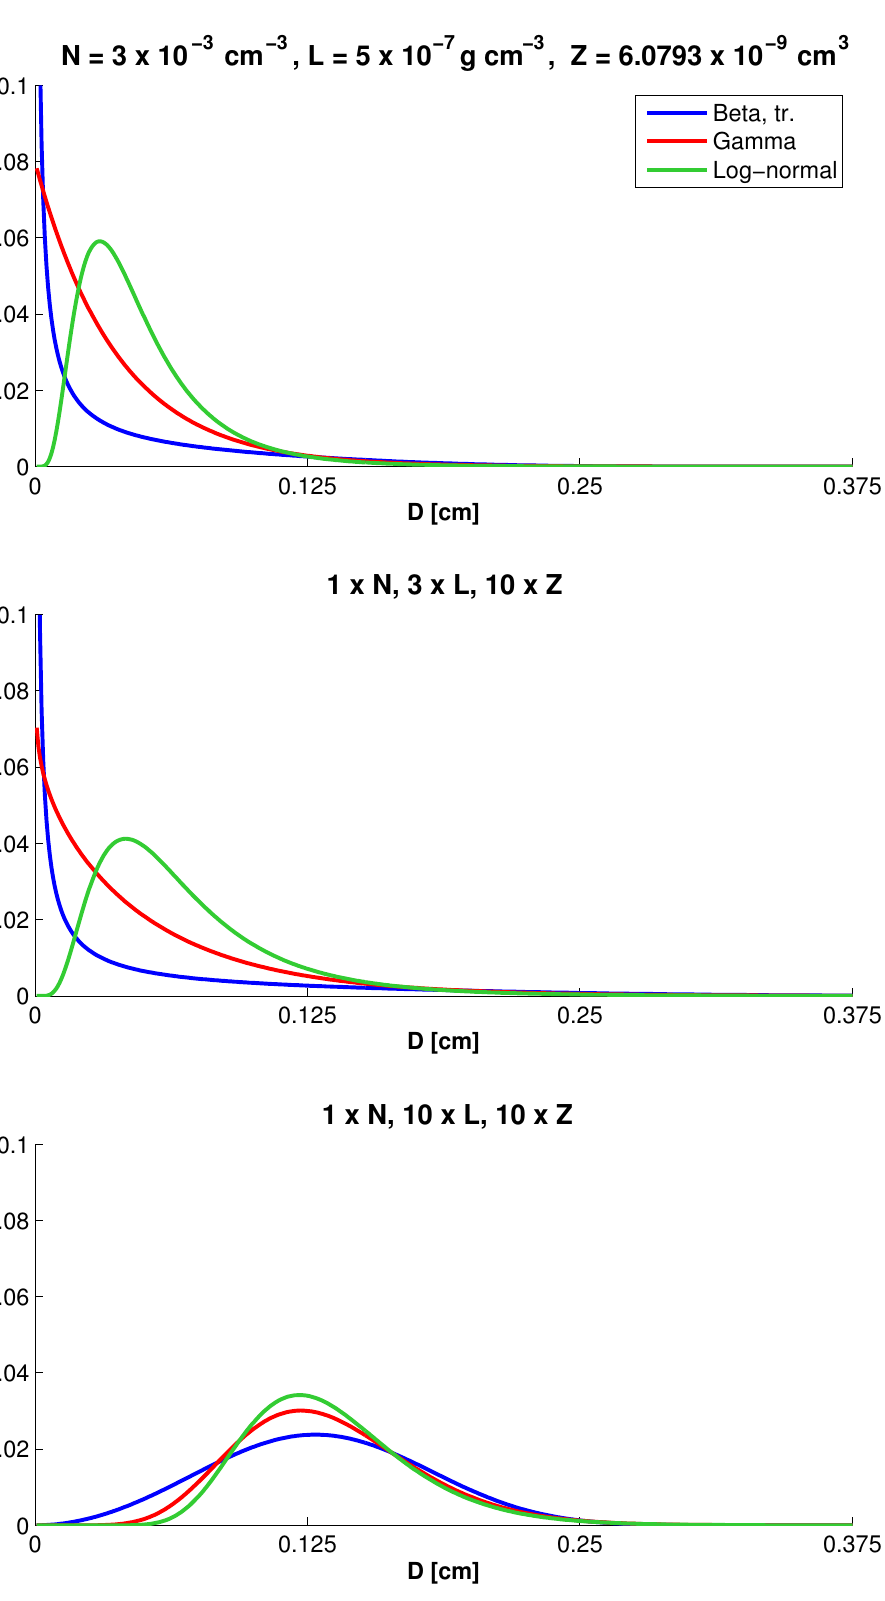
Figure 1. Representation of selected combinations of moments in the different distributions (colors). Top panel: N = 3 × 10 − 3 cm − 3 , L = 5 × 10 − 7 g · cm − 3 , Z = 6 . 0793 × 10 − 9 cm 3 (37.84 dB Z ). Middle panel: same N , 3 × L , 10 × Z . Bottom panel: same N , 10 × L , 10 × Z